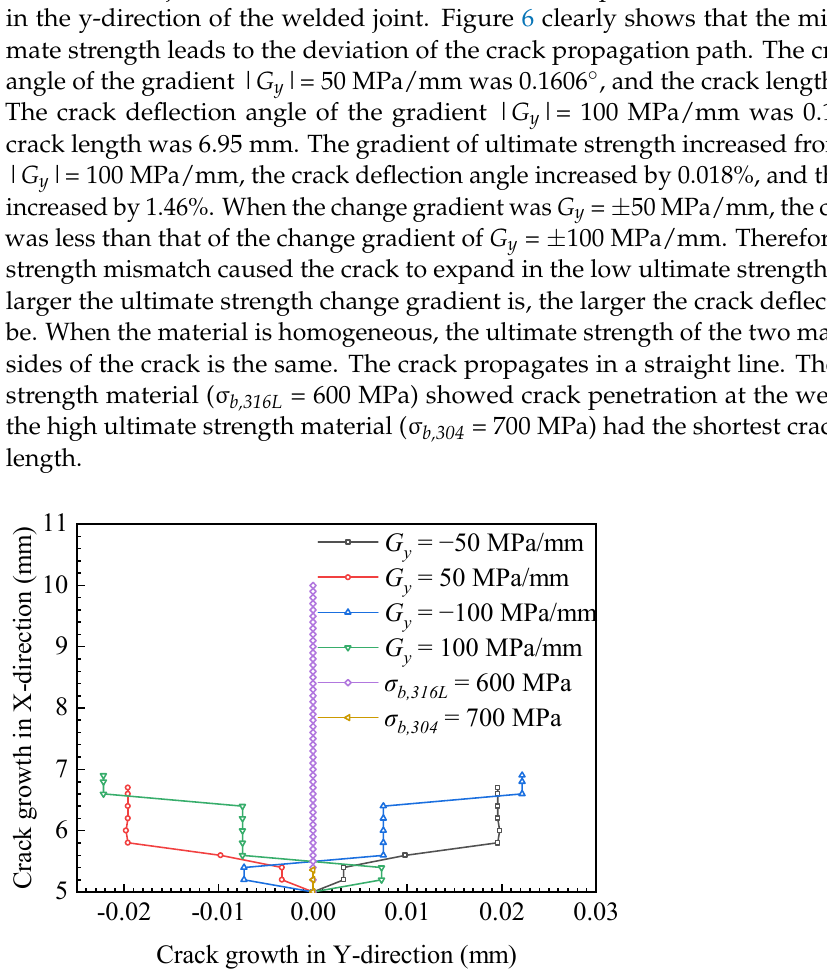
Figure 6. Crack propagation paths with different ultimate strength mismatch coefficients in the y ‐ direction.